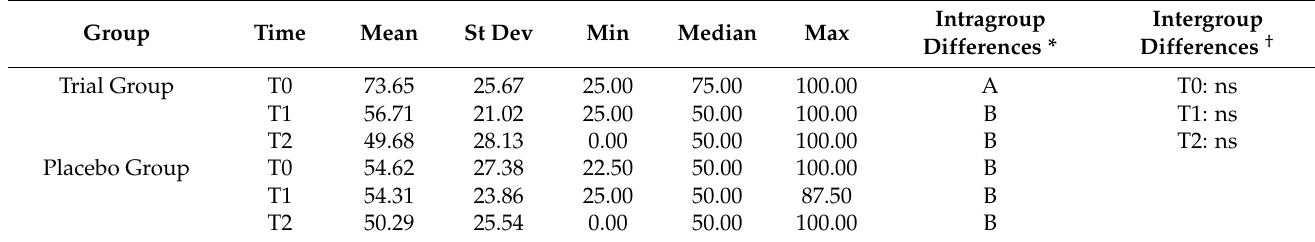
Table 3. Descriptive statistics of Plaque Index measurements (PI%).